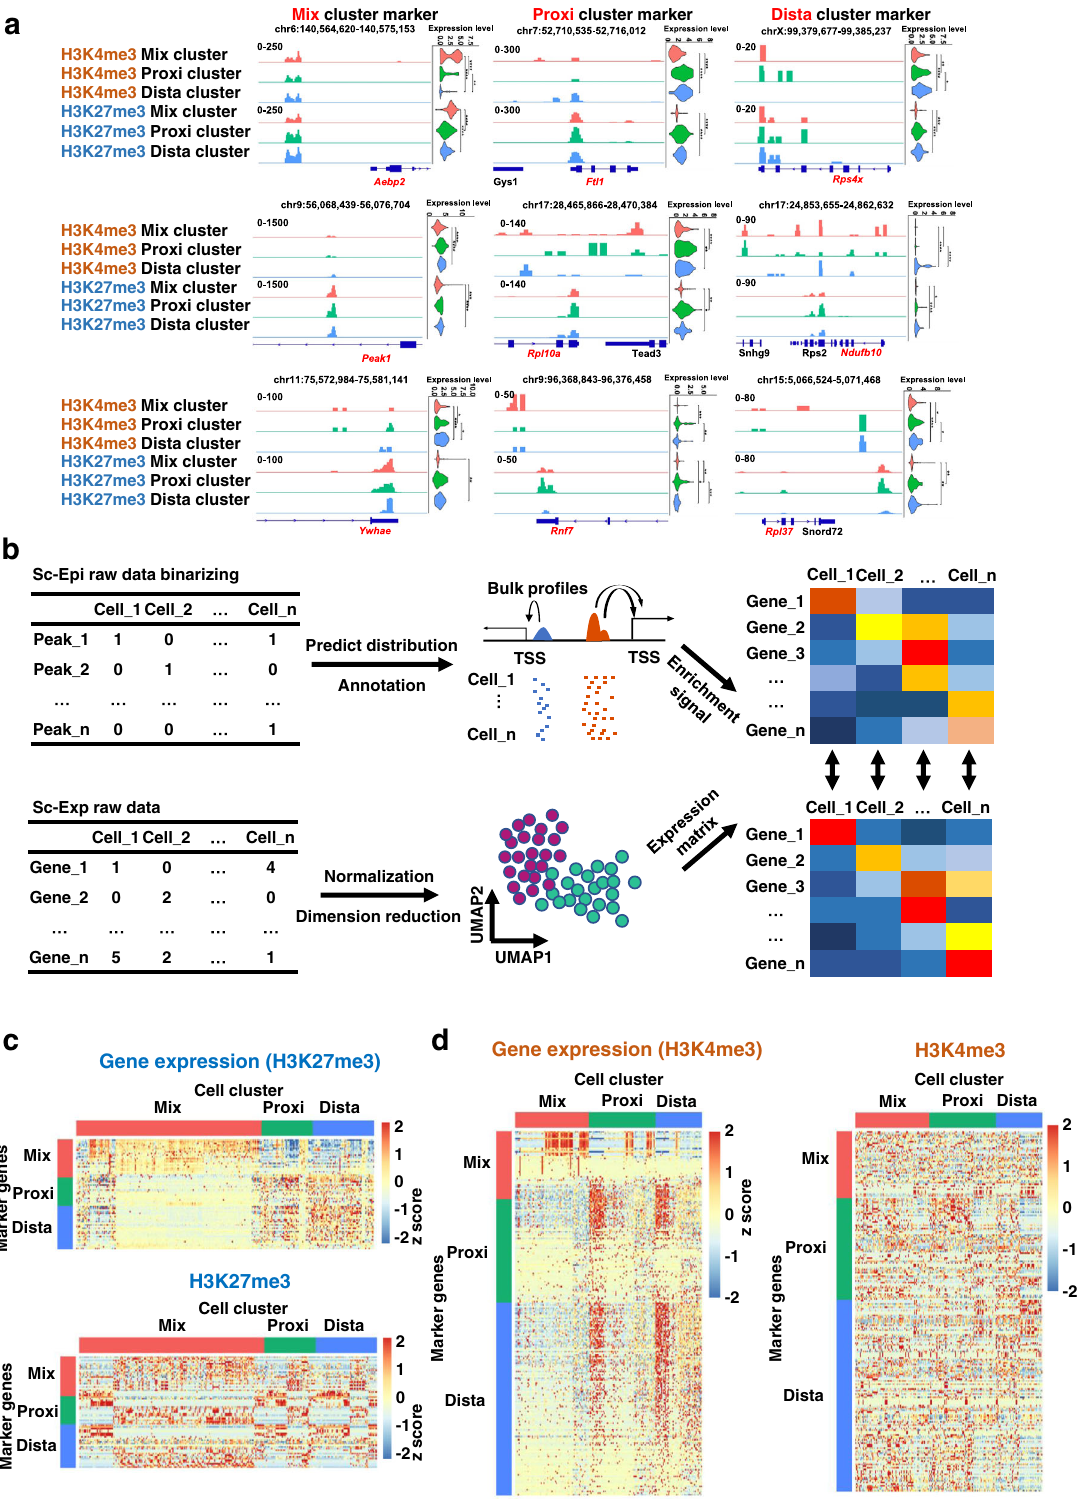
We selected marker genes with detected signals for both the epigenome and transcriptome to visualize the H3K27me3 and H3K4me3 scSET-seq results in heatmaps (Fig. 3c, d). We noticed that fewer marker genes were selected in H3K27me3 scSET-seq data than in H3K4me3 scSET-seq data because H3K27me3 was not detected around the marker genes. H3K27me3 may represent a repressive mark for gene